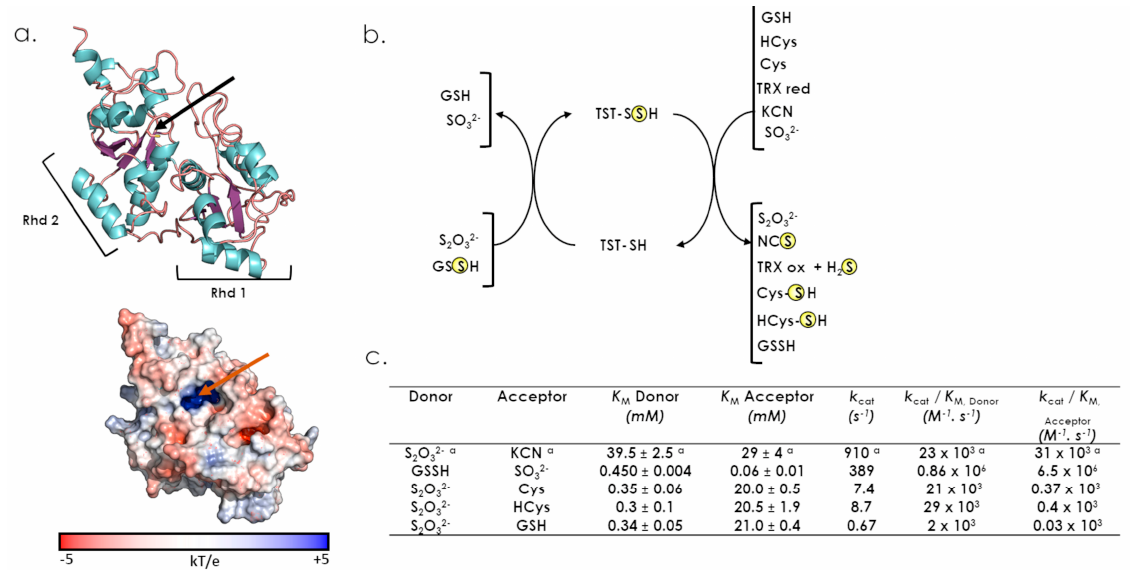
Figure 6. Structural and catalytic properties of TST. ( a ) Cartoon and surface representations of the TST structure (Alphafold AF-Q16762). The two Rhd domains are indicated. The active site cysteine is represented in stick and is indicated by a black (cartoon) or a red (surface) arrow. ( b ) describes sulfur donors or acceptors for TST. ( c ) Steady-state kinetic parameters for the sulfurtransferase activity of TST ([45], except for a